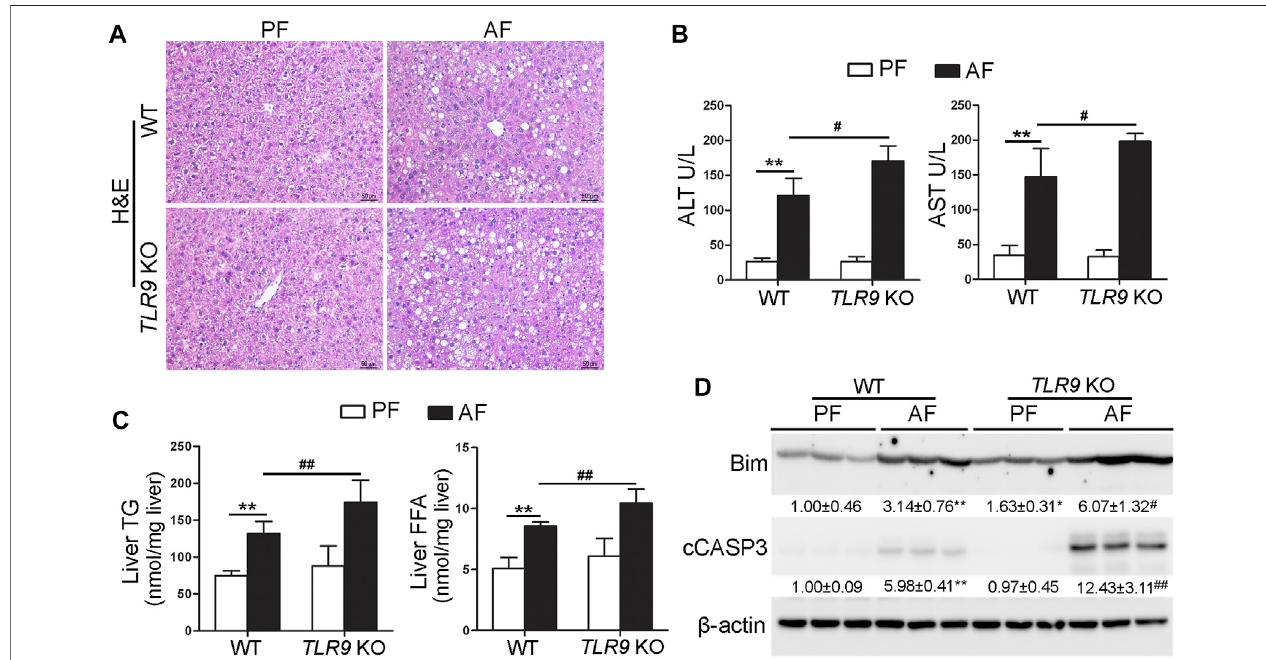
FIGURE1| Chronicalcohol feeding-induced liverinjury wasexacerbated by TLR9 KO. TLR9 KO and wild-type malemice werepair-fed or alcohol-fed for8 weeks plus a single binge ofethanol (4 g/kg) before 4 h of tissue collection. (A) Liver histopathological changes shown by H&E staining. Scale bars: 50 μ m. (B) Serum ALT and ASTactivities. (C) LiverTGandFFAlevels. (D) WesternboltanalysisofhepaticBimandcleavedcaspase-3.Proteinbandsintensitywasquanti fi edbyImageJ(NIH).Data are presented as means ± SD. ** p < 0.01 vs. WT/PF mice; # p < 0.05, ## p < 0.01 vs. WT/AF mice. PF, pair-fed; AF, alcohol-fed.